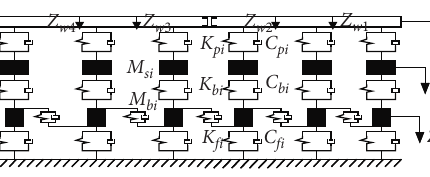
Figure 2: Track calculation model.